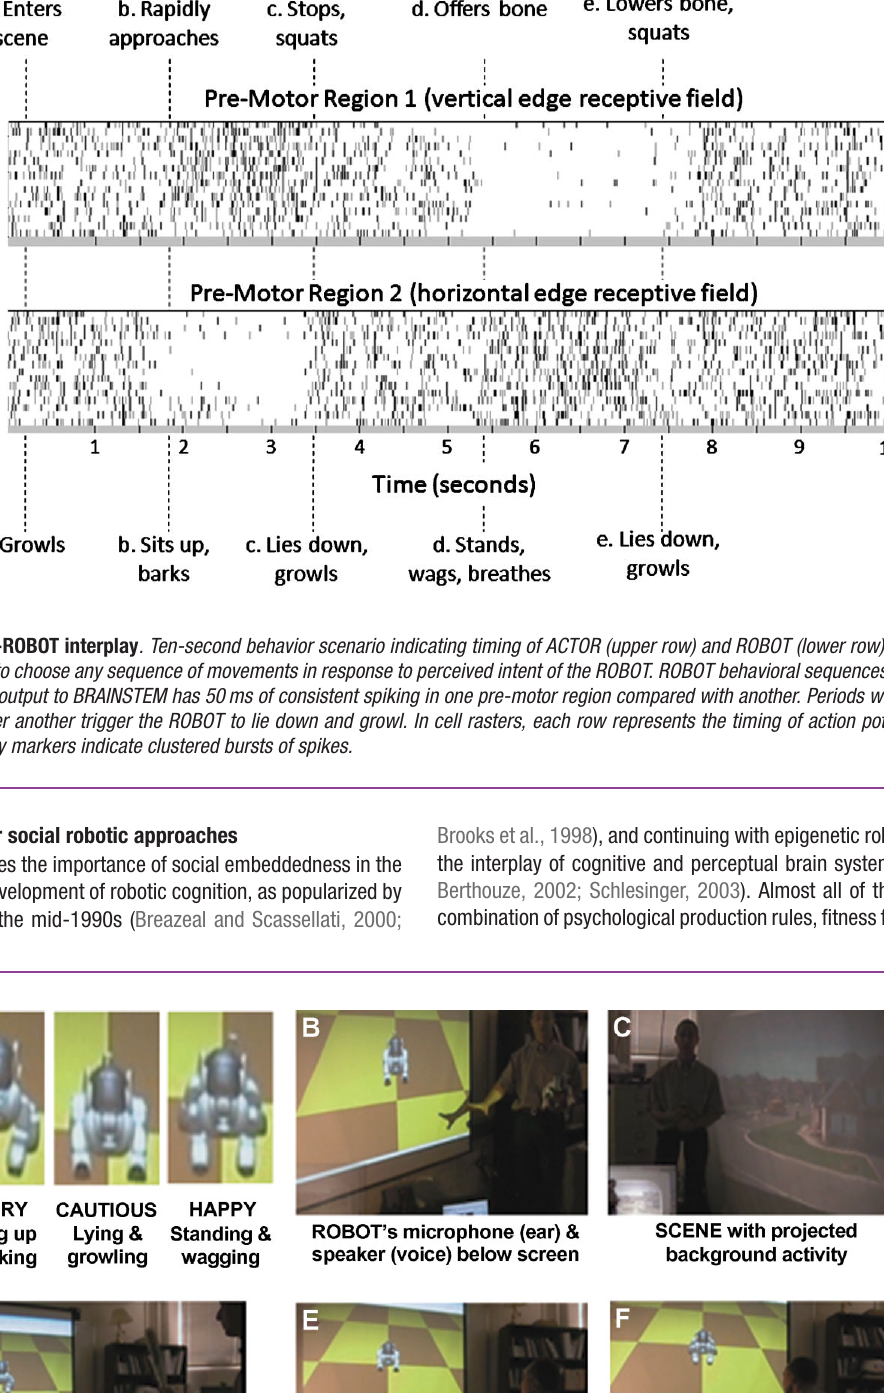
Figure 4. DemonstrationofVNRinteraction .Thesystemiscomprisedofthreemaincomponents,SCENE,ACTOR,andROBOT,asviewedbyanexternalobserver. ( A ) Three major behaviors of the ROBOT. ( B ) Positioning of ROBOT’s external sensory devices. ( C ) Background scene consisting of suburban neighborhood. ( D–F ) VNR loop (ROBOT-eye view superimposed in lower left corner): ( D ) ACTOR approaches with threatening behavior (bat) and ROBOT responds by sitting up and barking. ( E ) ACTOR responds by lowering bat and squatting down, then ROBOT responds by lying and growling a warning. ( F ) ACTOR offers dog bone and ROBOT responds by standing and wagging tail. Online video,